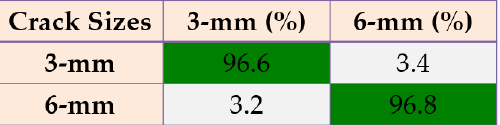
Figure 26. The average of crack size (3 mm and 6 mm) diagnosis using the combination of PDT and SVM approach for all abnormal conditions.